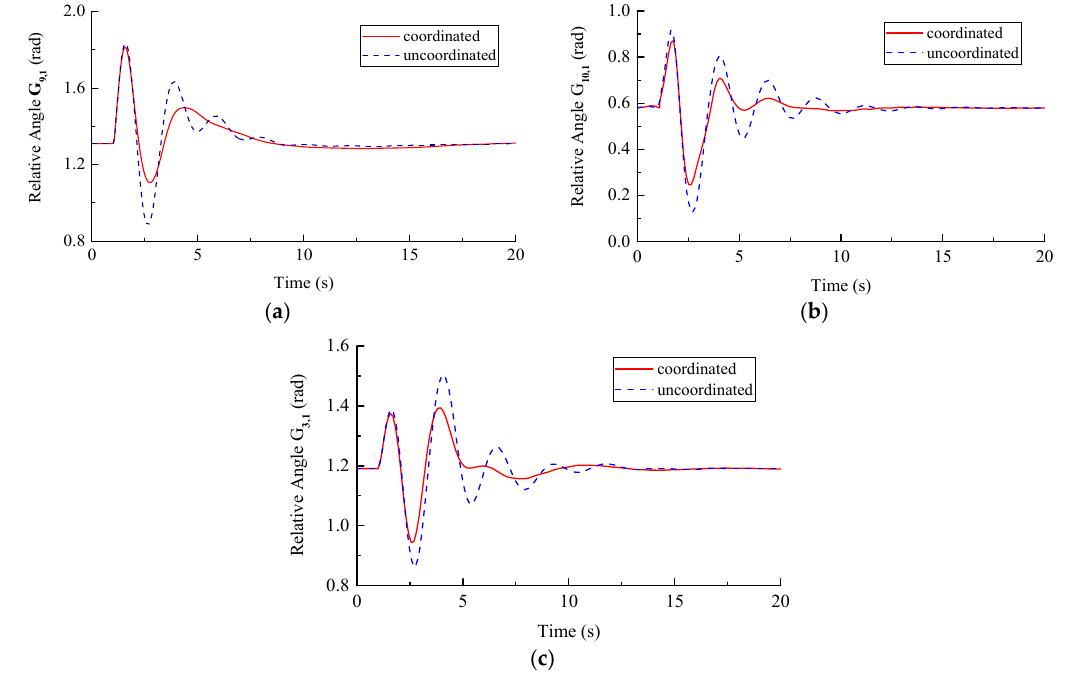
Figure 17. Relative power angle response of synchronous generators under different test scenarios (solid line: coordinated; dot line: uncoordinated). ( a ) Power outputs of wind farms are decreased to 100 MW; ( b ) Load increase 10%; and ( c ) Line 14–15 and 21–22 outage.